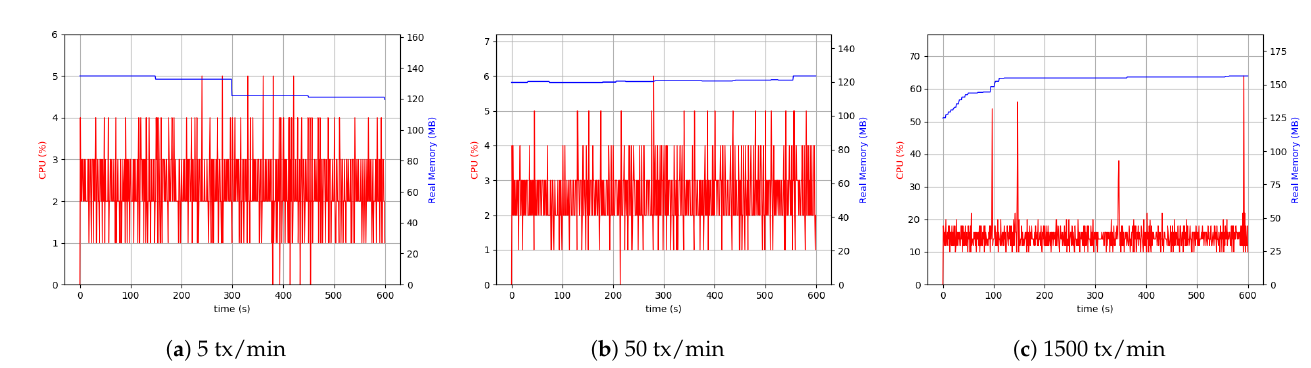
Figure 12. CPU and memory use for varying data sizes for peer process in the Desktop setup.